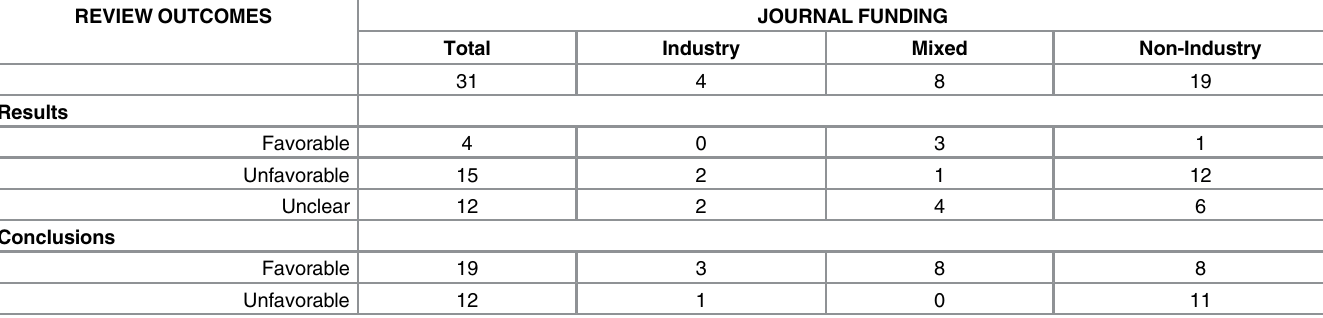
Table 5. Results and conclusions of reviews by journal funding (n =